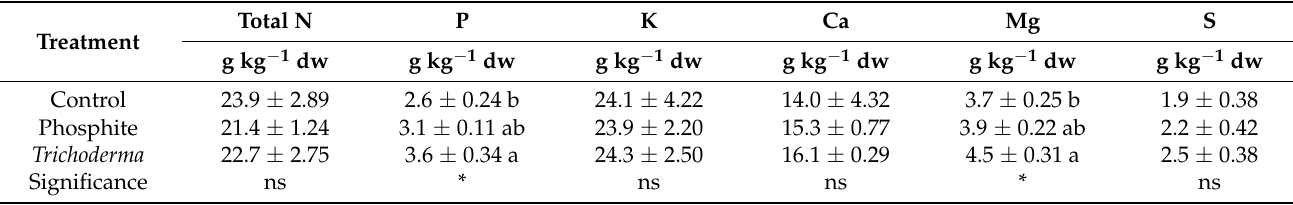
Table 2. Effects of phosphite and Trichoderma application on total nitrogen and minerals accumulation of zucchini squash